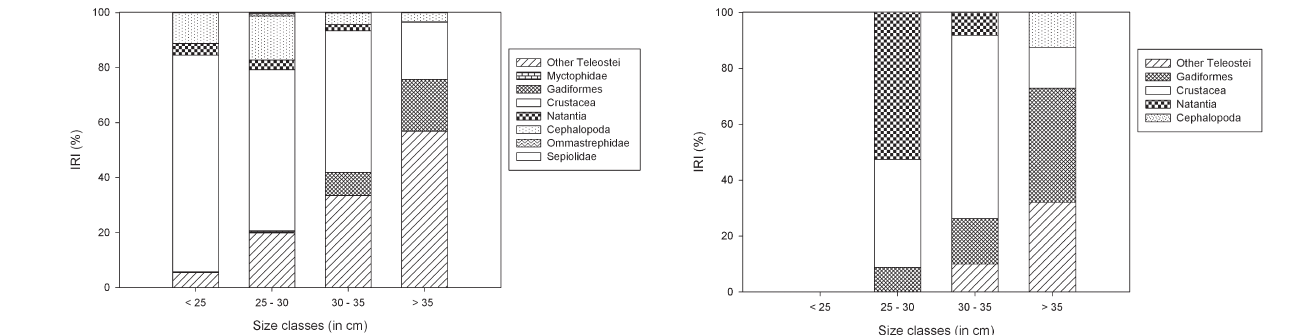
Fig . 5. – Index of relative importance (%IRI) of prey items in re- lation to the size classes Etmopterus pusillus . Data from longline gear only. Crustacea includes all unidentified crustaceans except for Natantia. (Number of specimens with TL ≤ 25 cm=0; 26-30 cm=7; 31-35 cm=33; and >35